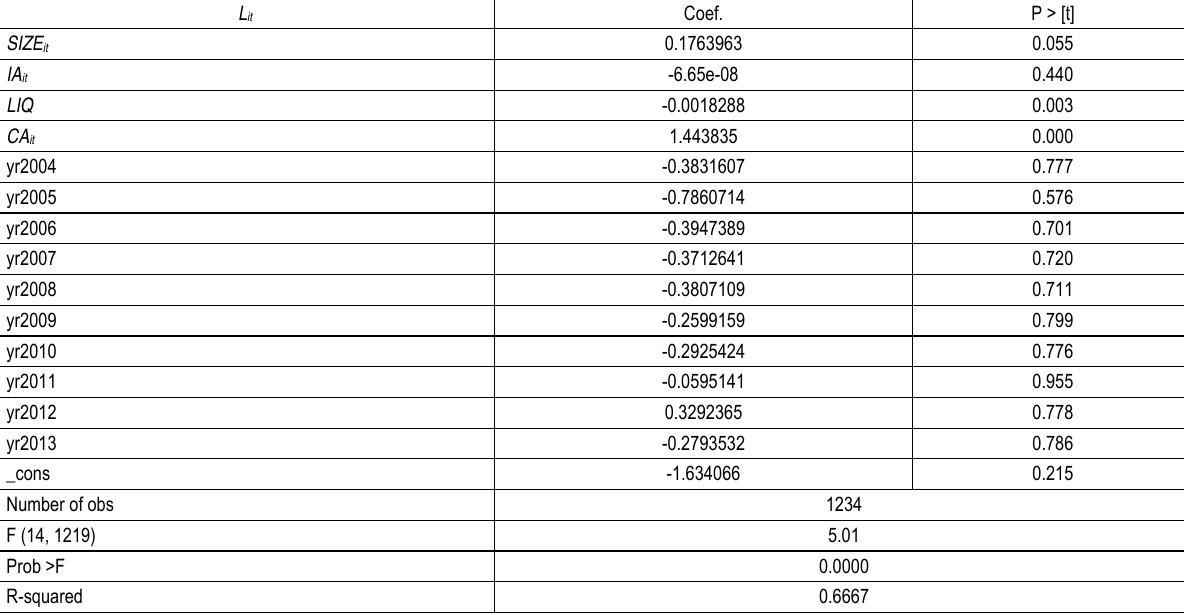
Table 2. Regression results, Model